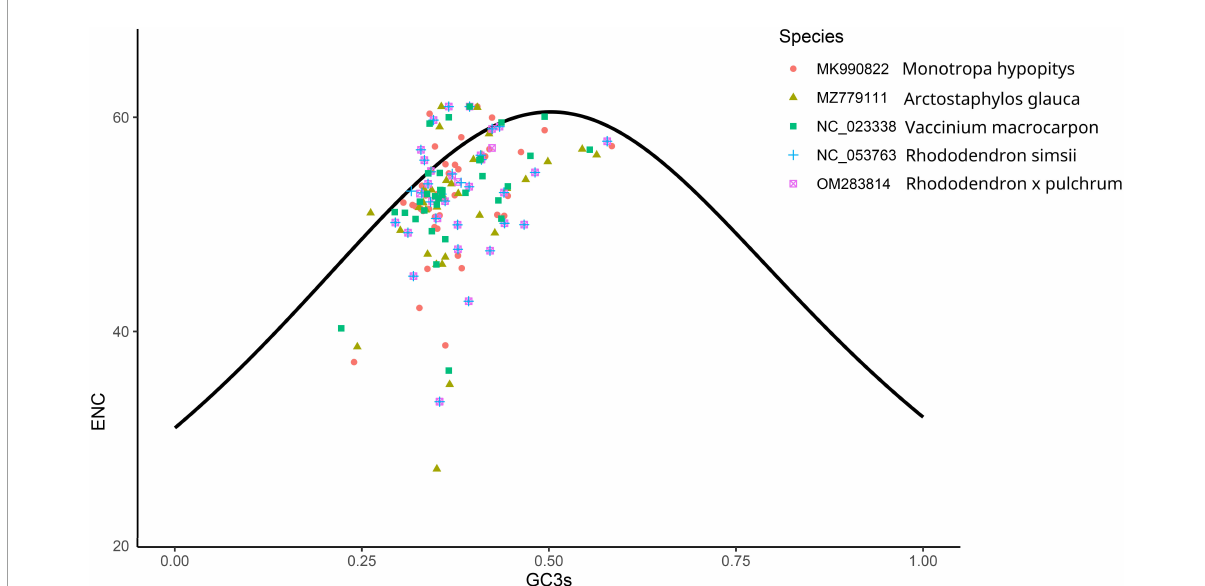
FIGURE7 ENC Plot analysis of genes in 5 Ericales species mitochondrial genomes. (Y-axis: Effective number of codons value of gene; X-axis: GC3 content of gene; Standard curve line is calculated as follows: ENC = 2 + GC3 + 29/(GC3 2 + (1-GC3) 2 ).